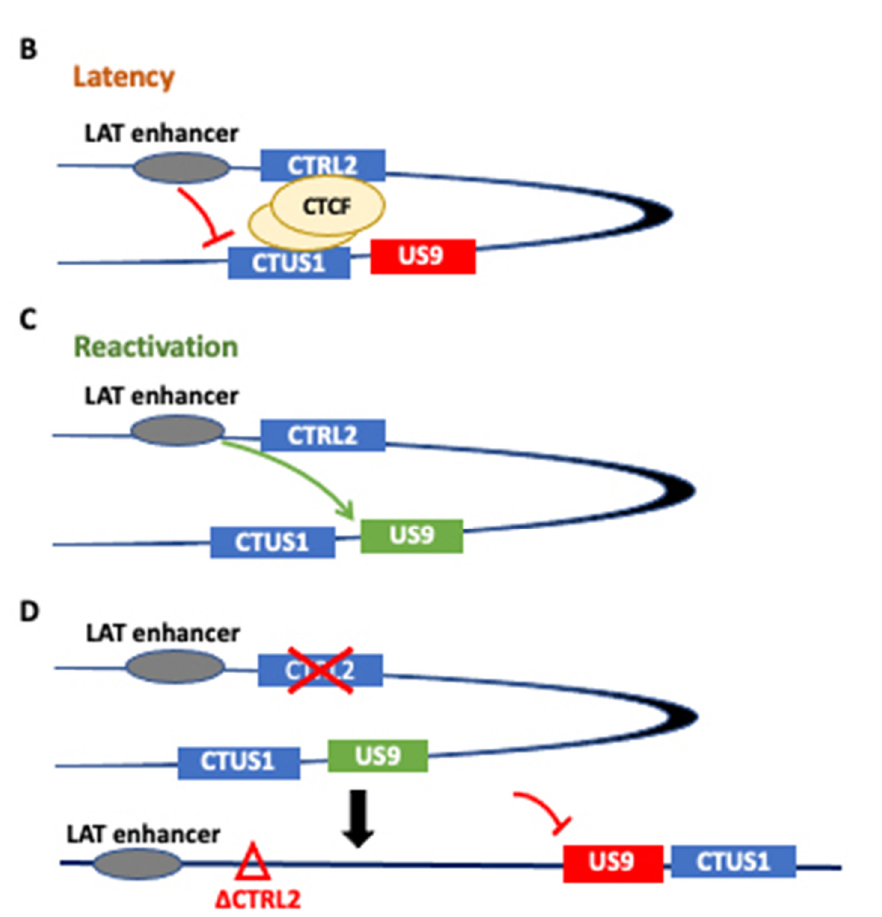
Figure 7. ( A ) A potential model for the CTRL2-regulated gene expression of Us9. We hypothesize that the CTRL2 insulator dimerizes with CTUS1 near the Us9 region of HSV-1 to establish a chromatin loop that would support positioning the LAT enhancer in close proximity to Us9. Our model proposes the following mechanism for HSV-1 reactivation from neurons. ( B ) During latency, CTCF insulators CTRL2 and CTUS1 self-dimerize to position the LAT enhancer in spatial proximity to the Us9 gene. During latency, these insulators are occupied by CTCF protein, acting both as an enhancer blocker to the LAT enhancer and preventing the expression of Us9. ( C ) In reactivation, the CTCF protein is evicted, thereby allowing for the LAT enhancer to activate the Us9 promoter. ( D ) In the absence of the CTRL2 insulator, the spatial orientation between the LAT and Us9 regions is disrupted, inhibiting efficient reactivation through a mechanism involving axonal